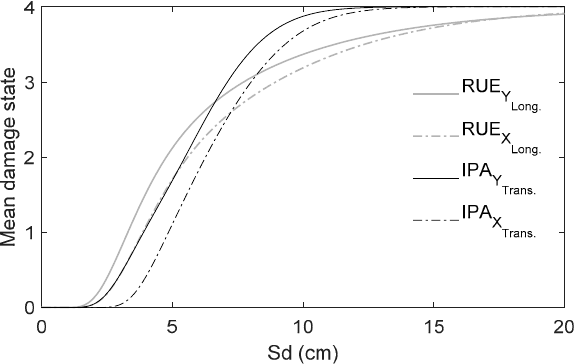
Figure 13. Mean damage state curves based on Risk-UE and Park and Ang damage-based index.